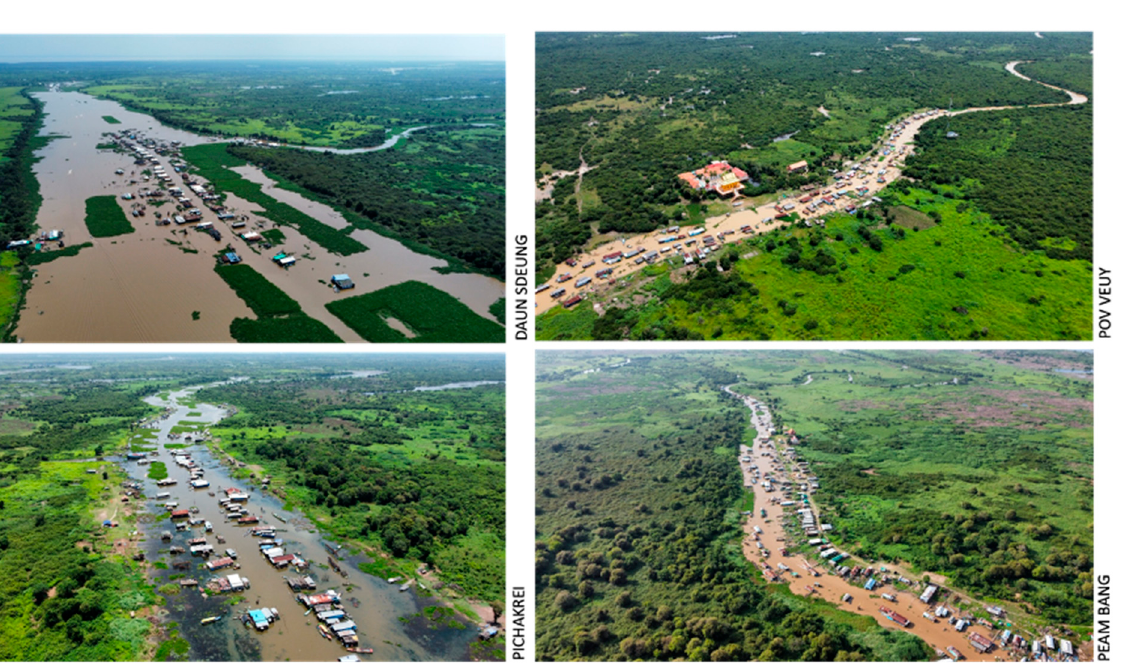
8 of 19 Figure 6. Territorial transect (Tonle Sap and Stung Staung river floodplain and settlements) and Boeng Chhmar’s floating villages. An overlay map of habitats, flood conditions, topography, village system, and urbanized area (Linh Vu, 2022, mapping from GIS open source, Cambodia topography, google earth, and fieldwork observations of floating village locations in dry and flooding seasons). In the dry season (from November to April), the floating villages anchor to land which becomes the common area for social and intuitional formation through the building of ritual and social facilities. Inhabitation occurs either on the muddy, shallow waters bridging the open water and land or by moving through the waterways to upstream areas